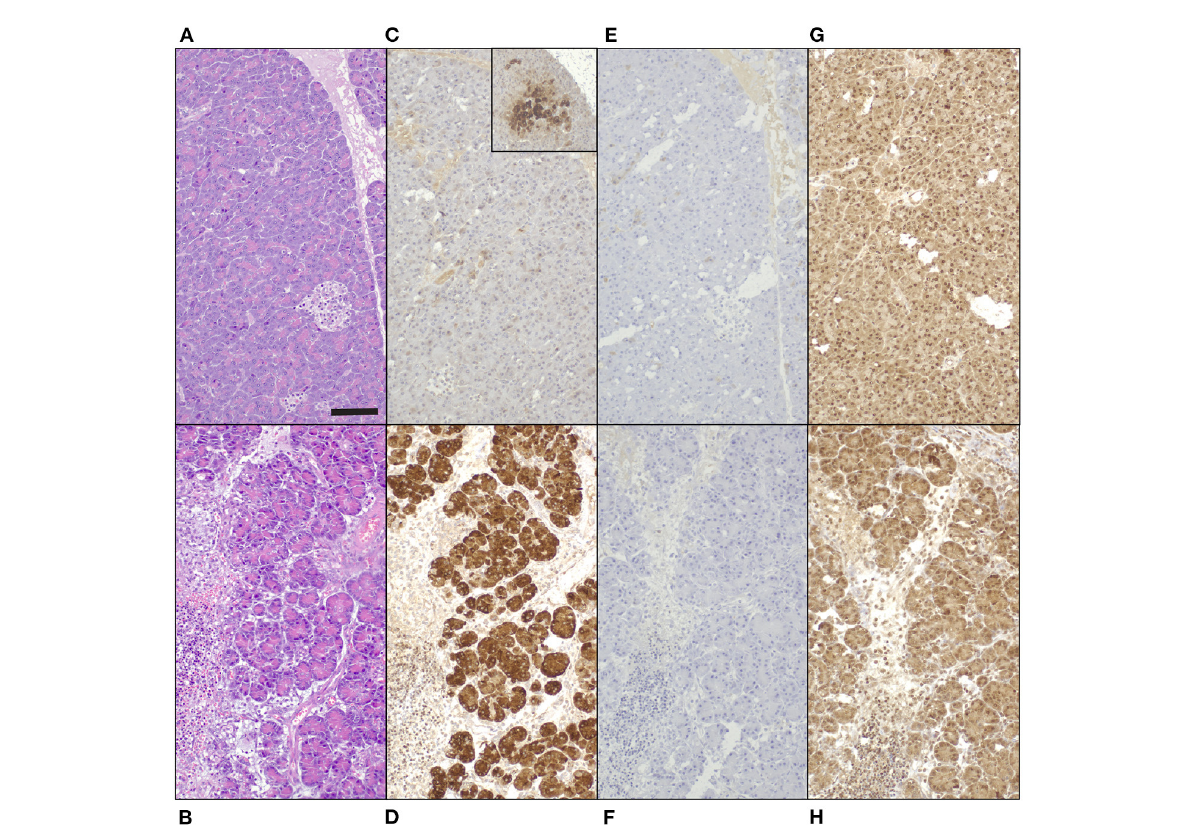
FIGURE4 Tissue biopsies of normal canine pancreas [top row; (A,C,E,G) ] and canine pancreas with acute pancreatitis [bottom row. (B,D,F,H) ], 200x magnification, bar = 100 µ m. (A,B) Hematoxylin and eosin. (C-H) 3,3-diaminobenzidine tetrahydrochloride dehydrate chromogen, hematoxylin counterstain. (C,D) Guinea pig anti-human REG3A antibodies produce minimal, patchy signal in healthy control tissue [ (C) inset 100x magnification], and strong cytoplasmic immunoreactivity in pancreatic acinar cells in acute pancreatitis (D). (E,F) No signal in neither tissue with guinea pig anti-human REG1A antibodies. (G,H) Non-specific, mainly nuclear signal in both tissues to rabbit anti-human REG1A